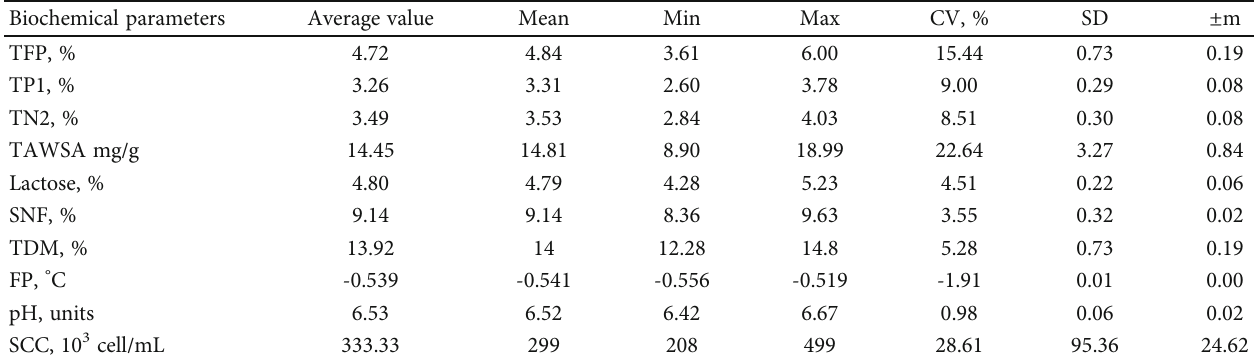
Table 2: The major biochemical parameters and component composition of milk samples ( n = 15 , group 2). Biochemical parameters